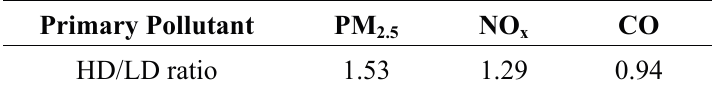
Table 5. The ratio of primary pollutant emissions from interstates (HD) and freeways (LD) based on the fleet mix for Detroit, MI, MOVES emissions tables for August